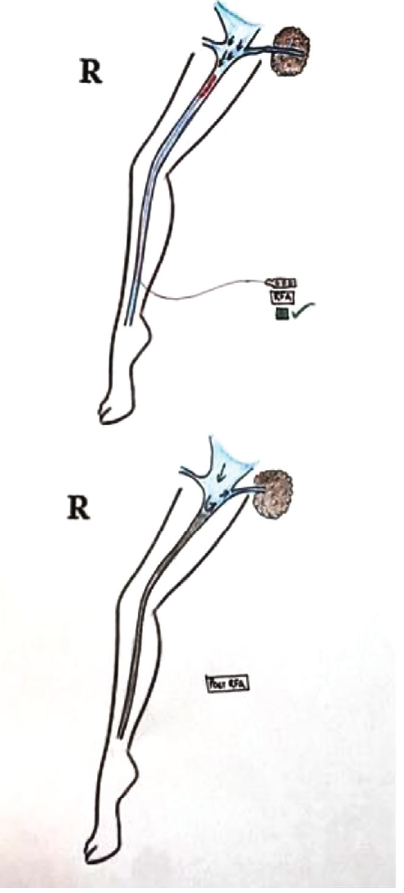
Figure 6: Schematic diagram showing a vessel draining a lymph node and RFA of GSV sparing a lymph node vessel.